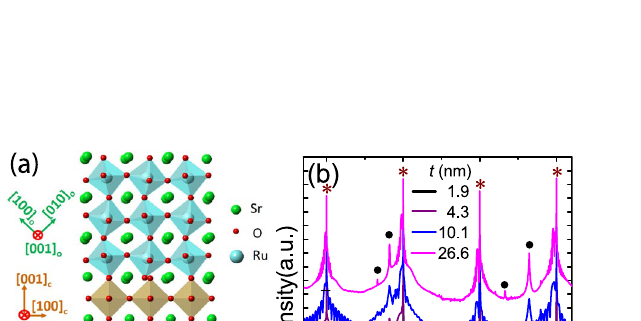
Figure 3. Surface morphology of a SRO film on STO before and after the growth. ( a ) AFM image of a TiO 2 -terminated STO substrate. ( b ) AFM image of a SRO film with t ≈ 9 nm. Lower panel of ( a ) and ( b ) show the line profile of the terraces, where the step-height of around 0.39 nm corresponds to one unit-cell height of STO. ( c ) Histogram of height distribution within the shaded region of ( a ) and ( b ). The film roughness remains nearly the same as that of the bare substrate.